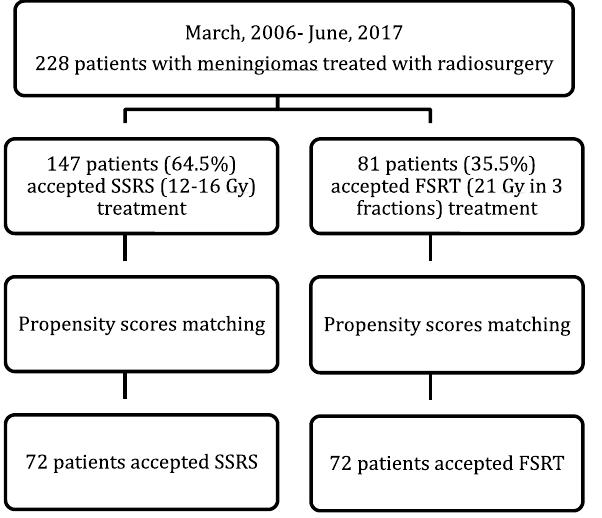
Figure 3. Flow chart demonstrating patients included in statistical analysis. SSRS single-session stereotactic radiosurgery, FSRT fractionated stereotactic radiotherapy..